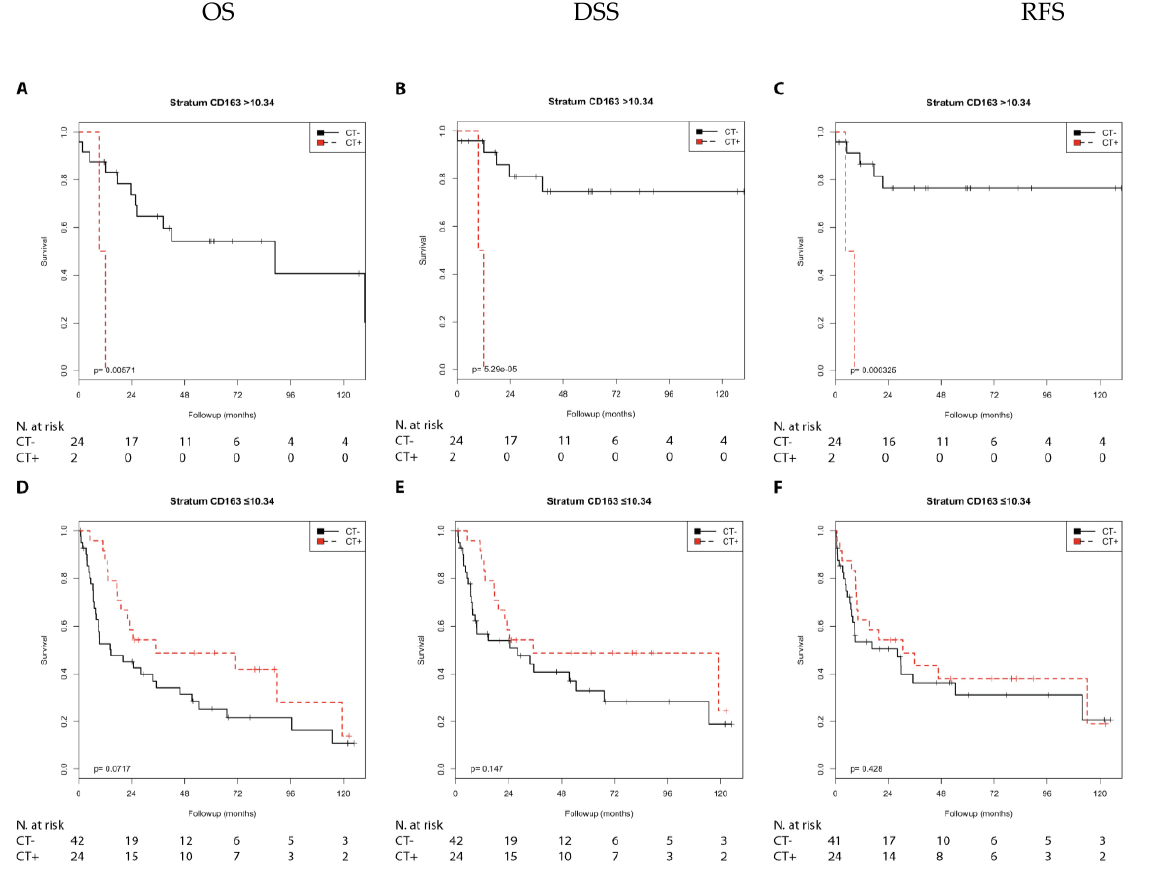
Figure 8. Kaplan–Meier analysis: Association of chemotherapy with prognosis (OS, DSS, and RFS) in the pT2/pT3 + 4 groups stratified by CD163 expression (>10.34 or ≤ 10.34). In the pT2 group ( A – C ) with CD163 (>10.34), chemotherapy was associated with shorter OS ( A ; p = 0.006), shorter DSS ( B ; p < 0.001), and shorter RFS ( C ; p < 0.001). In the pT3 + 4group ( D – F ) with CD163 (≤10.34), chemotherapy was not associated with OS ( D ), DSS ( E ), or RFS ( F ).